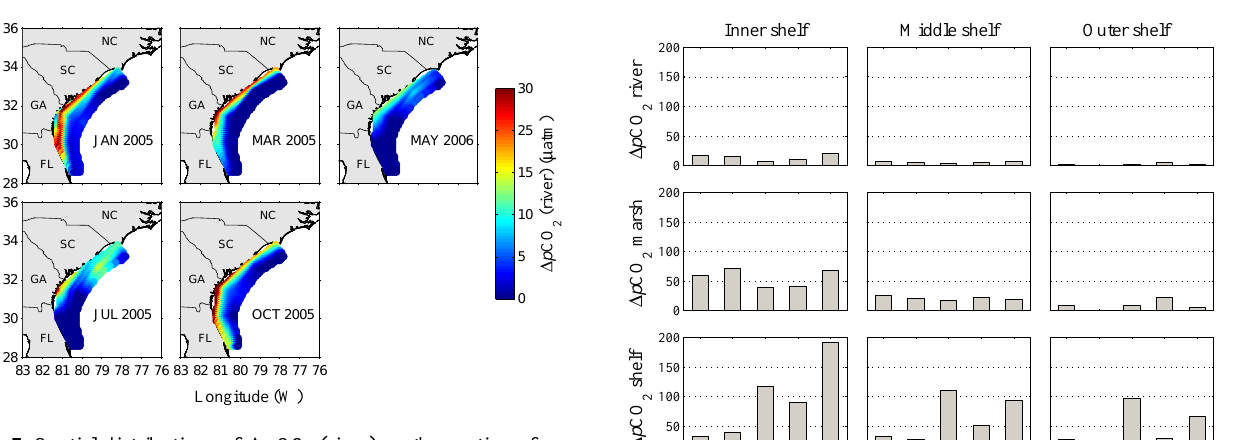
Fig. 7. Spatial distributions of 1p CO 2 (river), or the portion of sea surface p CO 2 that is due to inputs from the river (referenced to 23.11 ◦ C). Due to a lack of DIC data, 1p CO 2 (river) in Decem- ber 2005 is not presented. The colored contours are from triangle- based liner interpolation.